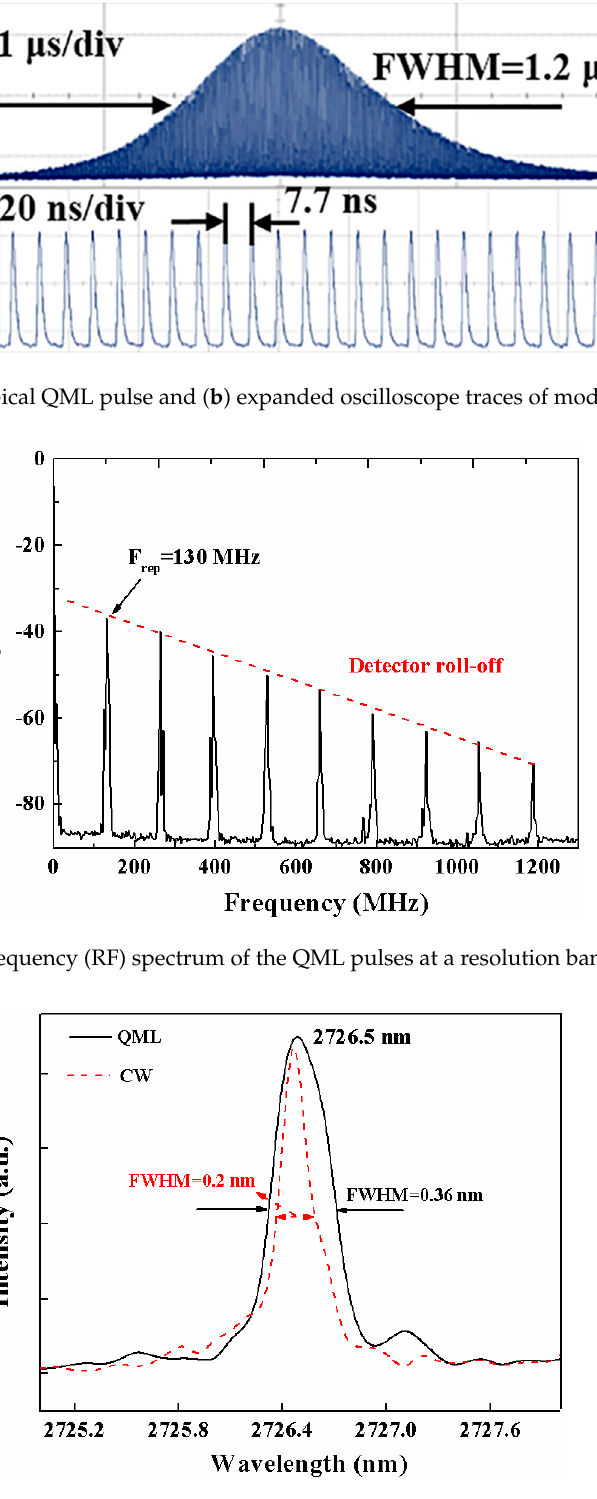
Figure 7. Output spectra in CW and QML modes of operation.